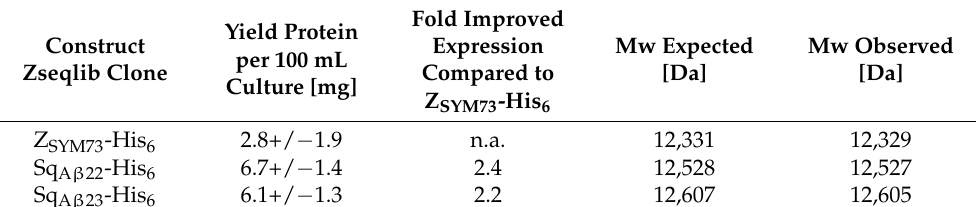
Table 2. Production yields compared to Z SYM73 . Expected mass in molecular weight (Mw)and observed molecular mass as determined by Mass spectrometry